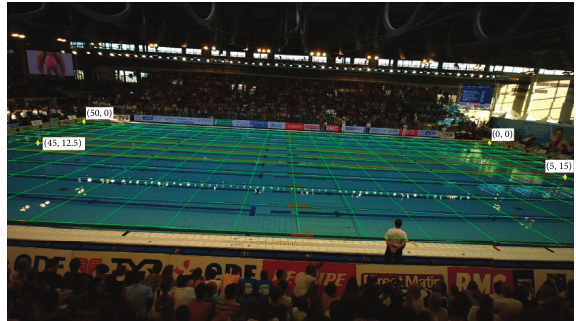
Figure 2: Calibration of the pool by the DLT technique using four selected points. Displaying a grid of 50 × 25m 2 where each cell represents an area of 2.5 × 2.5m 2 . Swimming Championships in Limoges, France, April 2015.